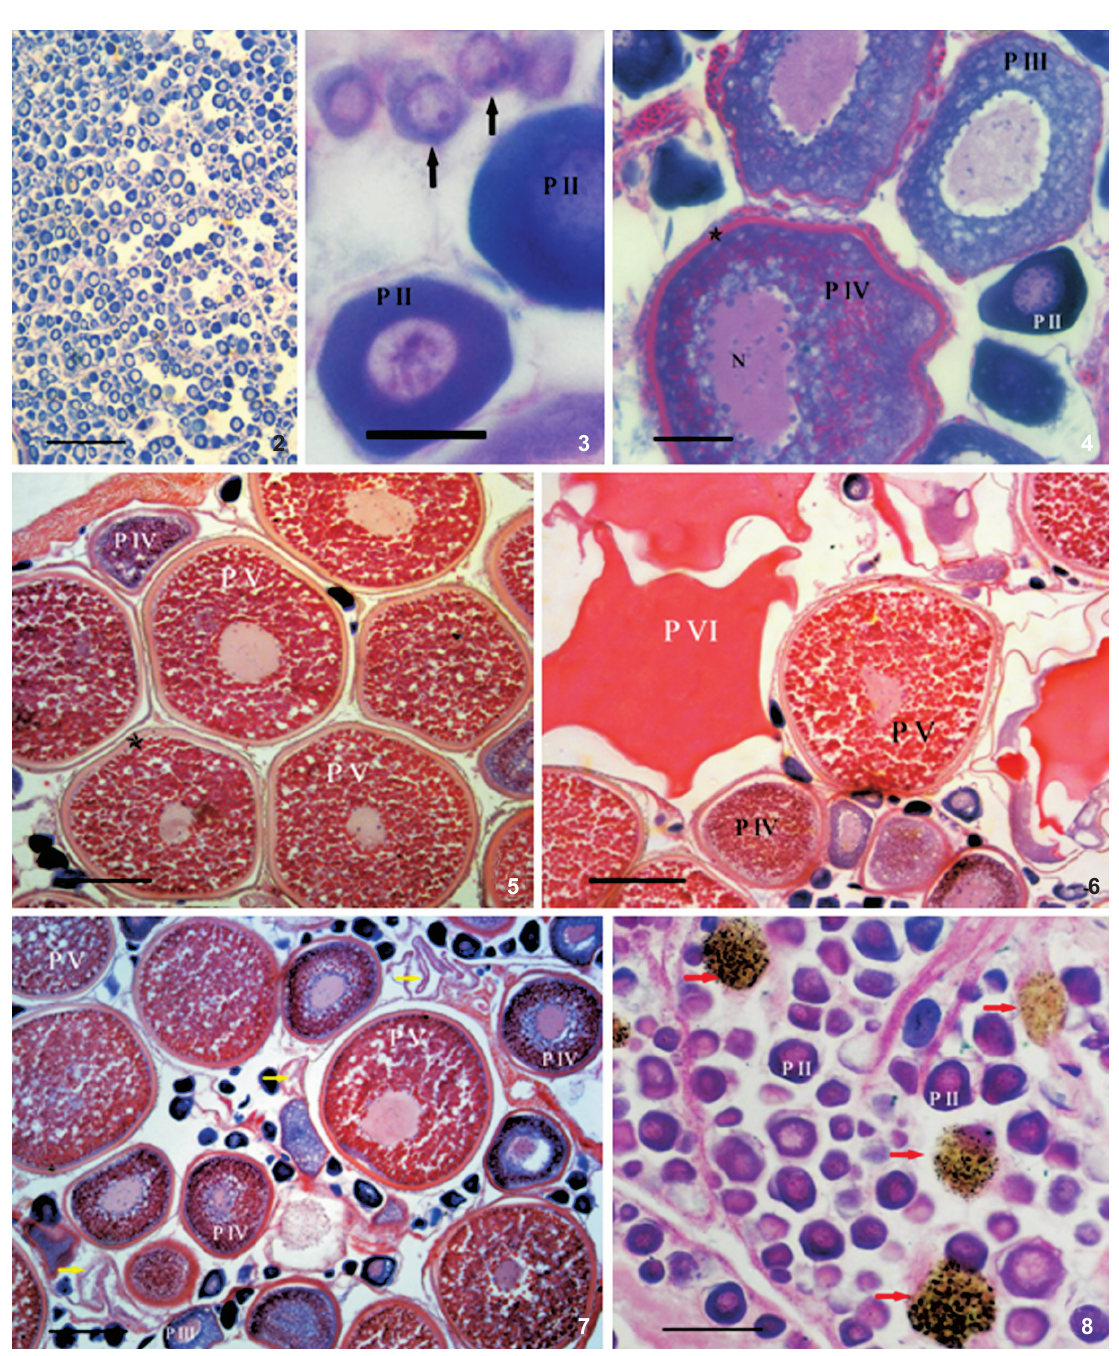
Figures 2-8. Histological sections of the ovaries of Achirus lineatus , HE staining: (2) immature ovary, scale 450 µm; (3) immature ovary, oogonia (arrow) and ovarian follicle in phase II (P II), scale 45 µm; (4) maturing ovary, ovarian follicle in phase II (P II), III (P III) and IV (P IV), vitelline membrane (star), scale 90 µm; (5) mature ovary, ovarian follicles in phase IV (P IV) and V (P V), scale 180 µm; (6) mature ovary, ovarian follicles in phase IV (P IV), V (P V) and VI (P VI), scale 180 µm; (7) partially spawned ovary, ovarian follicle in phase III (P III), IV (P IV), V (P V) and empty follicles (yellow arrow), scale 180 µm; (8) recovered ovary, ovarian follicles in phase II and residual bodies (red arrows), scale 180